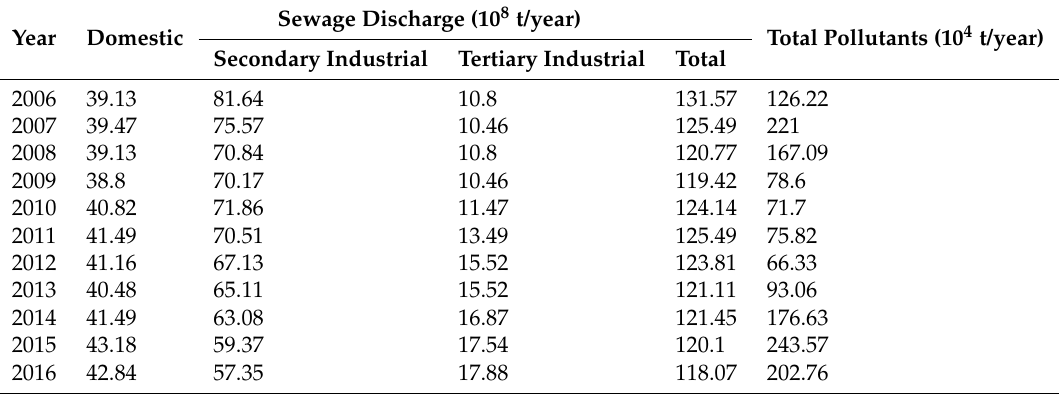
Table 4. Historical sewage discharge and total amount of pollutants from the Pearl River into the estuary